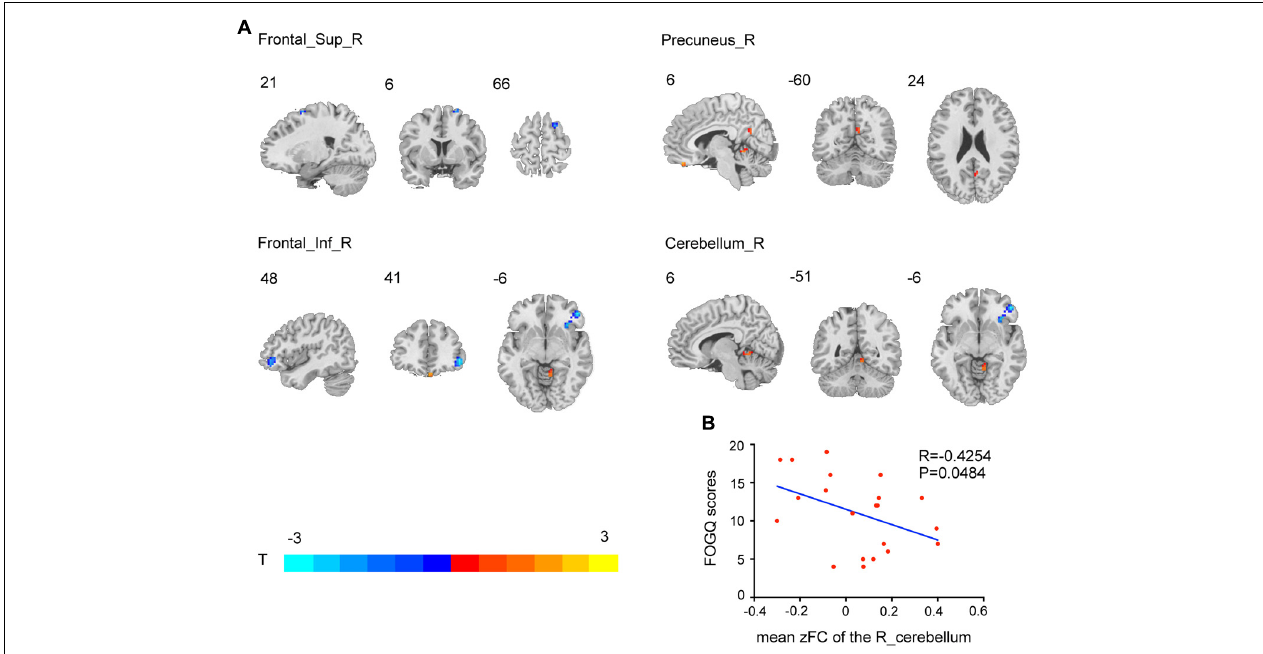
FIGURE 4 | Brain regions showing RMFG-related FC alterations in the PD-FOG group compared with the PD-nFOG group ( p < 0.001, AlphaSim-corrected). Red represents increased rsFC in the right precuneus and cerebellum, and blue represents decreased rsFC in the right inferior and superior frontal gyrus. The t -value scale is seen on the lower left of the image (A) . Correlations between FC and FOGQ scores. FOGQ scores were negatively correlated with impaired connectivity between the RMFG and right cerebellum in the PD-FOG group (B)